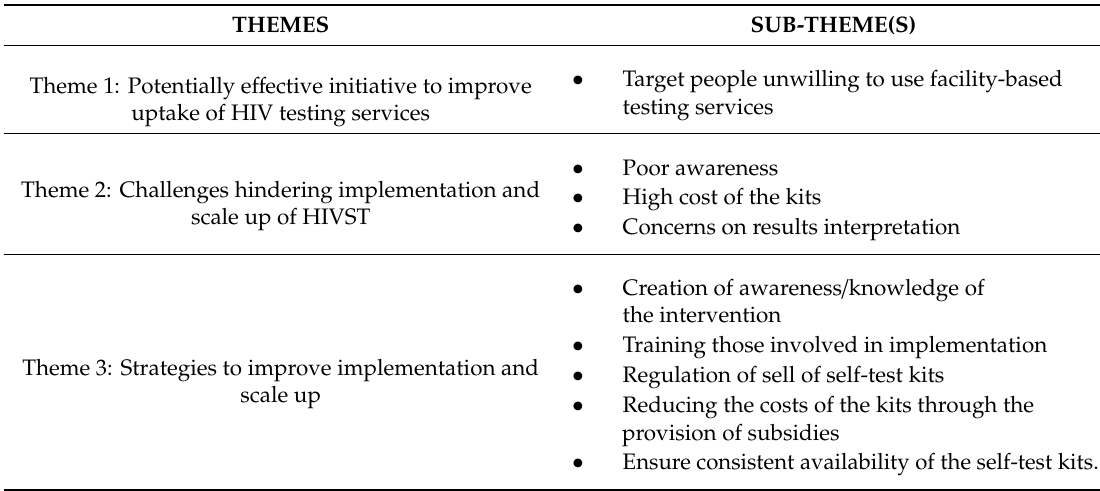
Table 2. Themes and